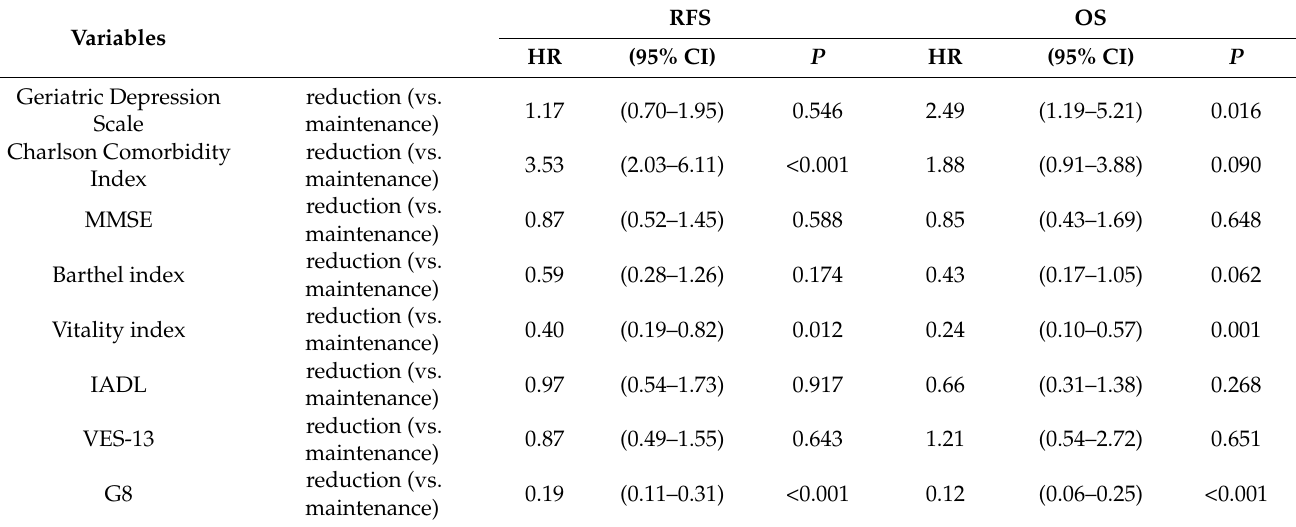
Table 2. Hazard ratios of eight geriatric assessment components for recurrence-free survival and overall survival in HCC patients aged ≥ 70 years who underwent hepatic